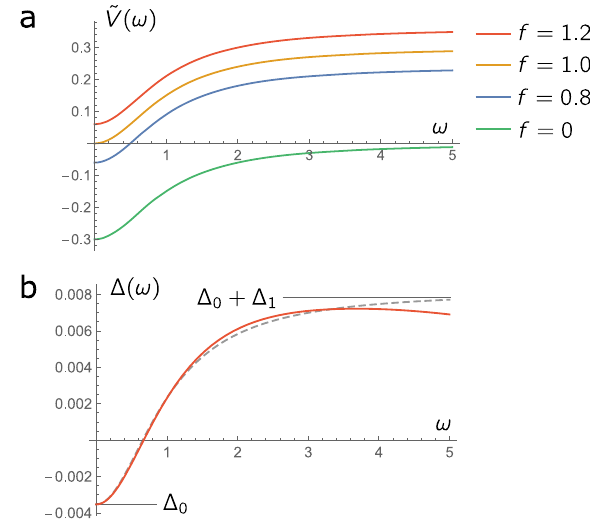
Fig. 1 Dynamical interaction and typical gap function. a ~ V ð ω Þ for Λ = 5, λ = 0.3 and four different values of f . b Numerical solution of the gap equation for f = 1.2. Gray dashed line corresponds to a fi t to Δ ( ω ) using the ansatz